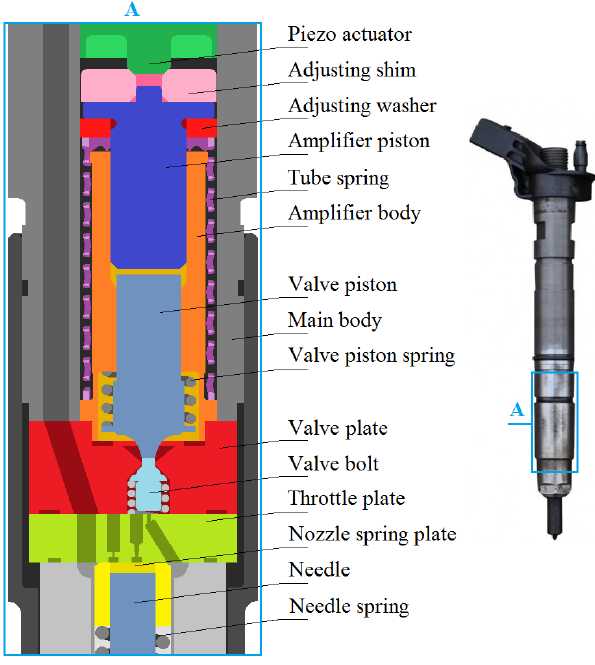
Fig. 1. Bosch CRI3-16 fuel injector design: own study based on [20] This type of fuel injector belongs to the third generation CRS3 (Common Rail System) systems, operating at